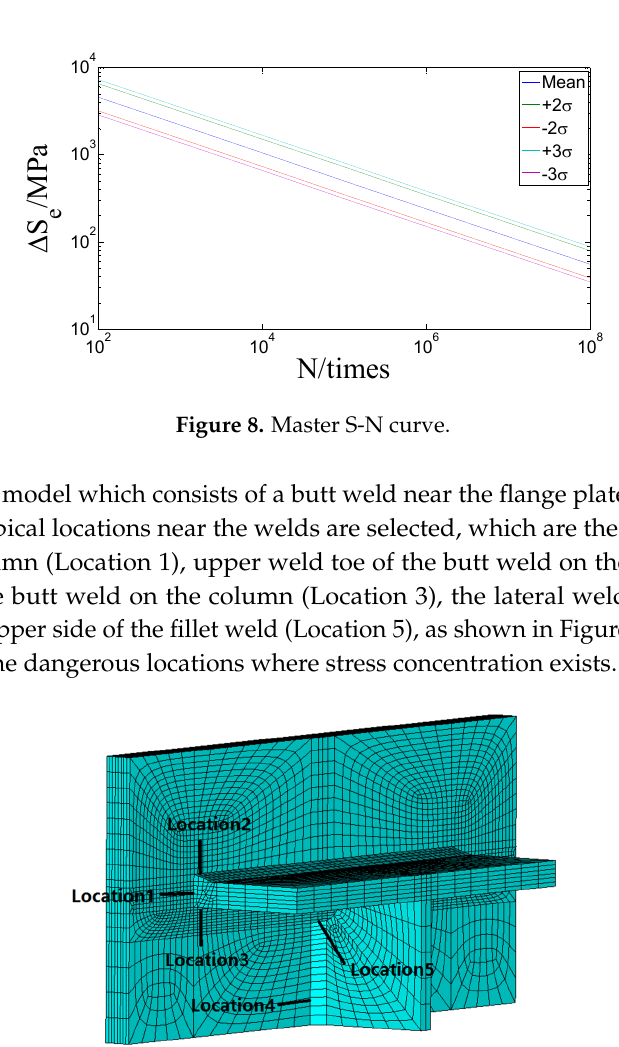
Table 1. Parameters for master S ‐ N curve.